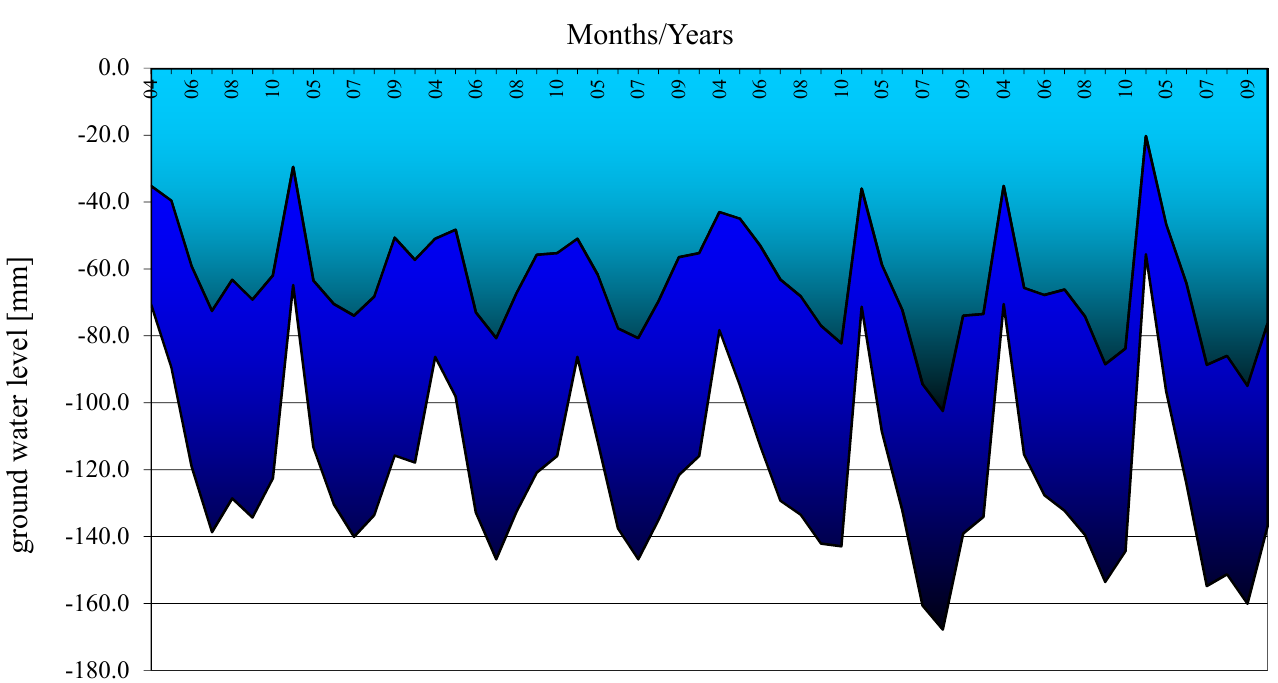
Figure 2. Grassland groundwater in 2012–2019, compared to the long-term average (1990–2019).